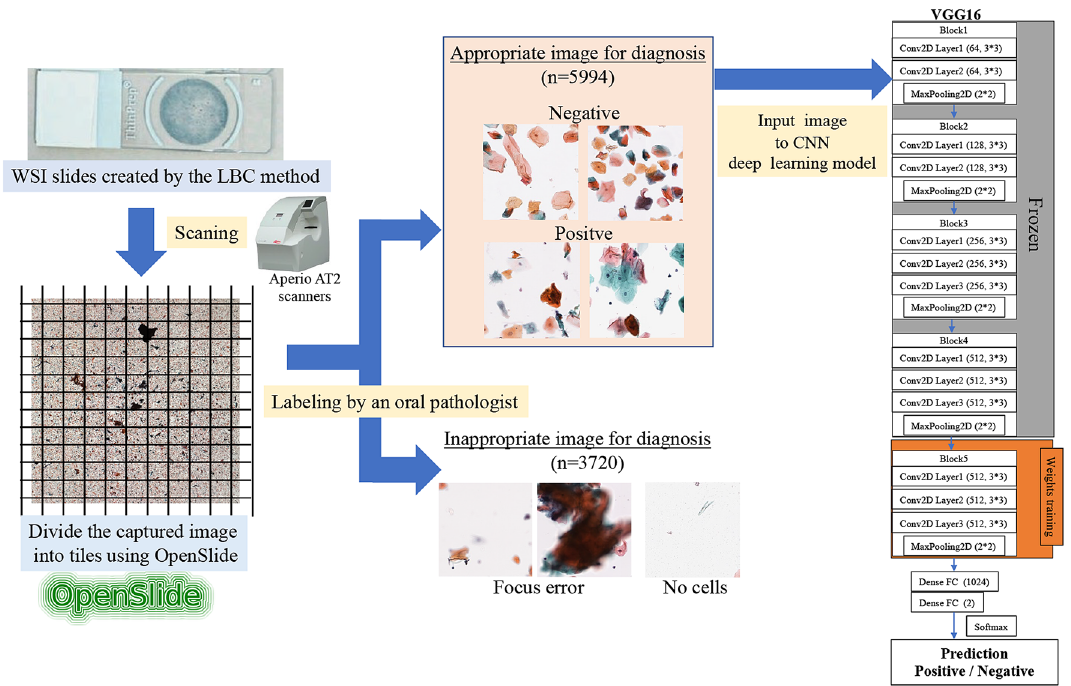
Figure 5. Overall flow of deep-learning classification model research of oral exfoliative